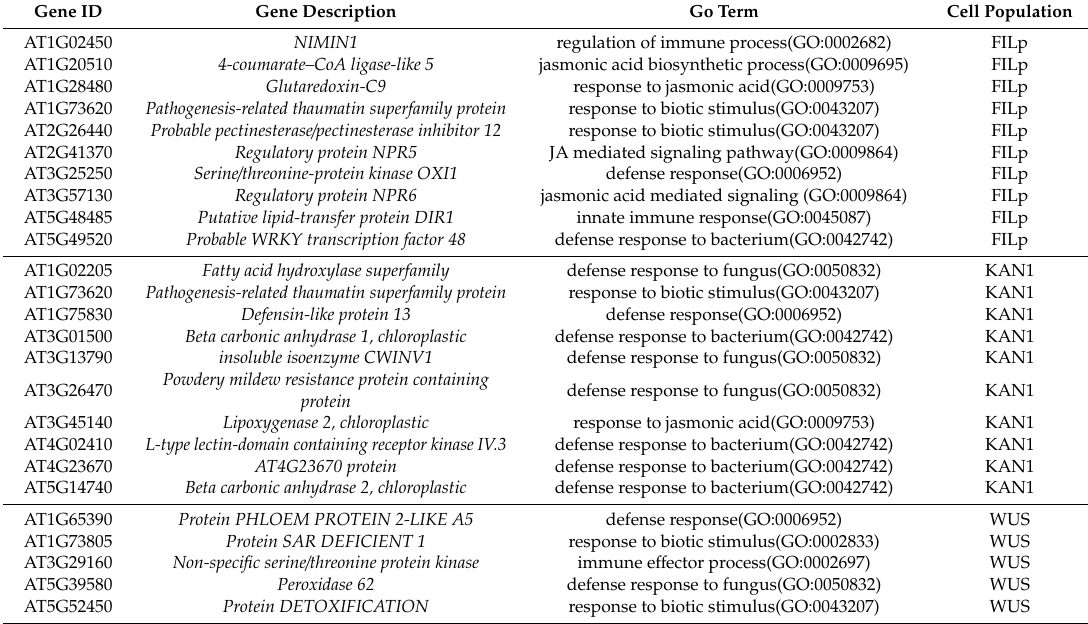
Table 4. Immune defense functions of DEGs belonging to FILp, KAN1, and WUS cellular populations.